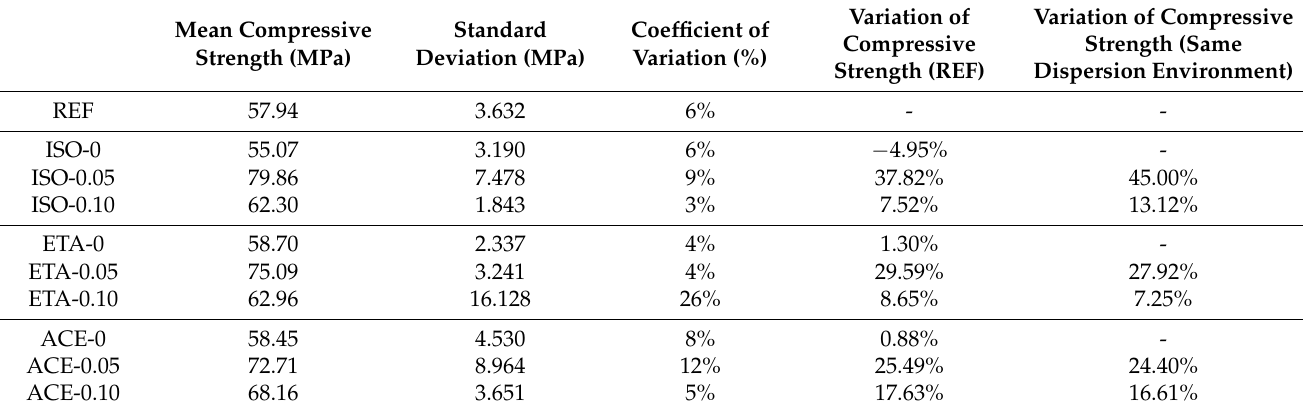
Table 4. Compressive strength test